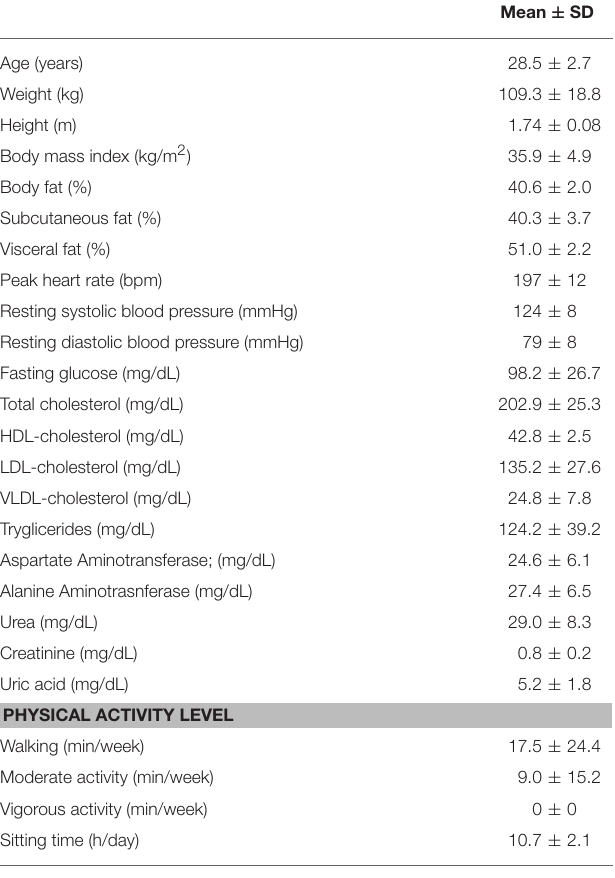
TABLE 1 | Characteristics of the subjects ( n =